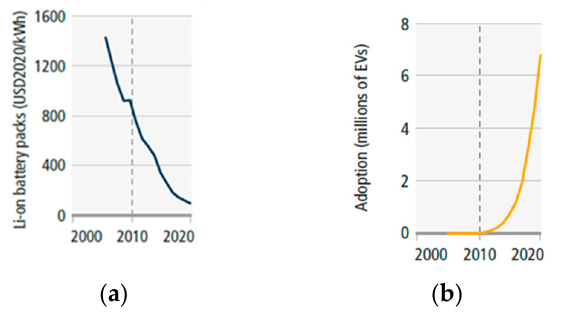
Figure 1. Correlated evolutions between ( a ) EV battery prices and ( b ) number of EVs [1].